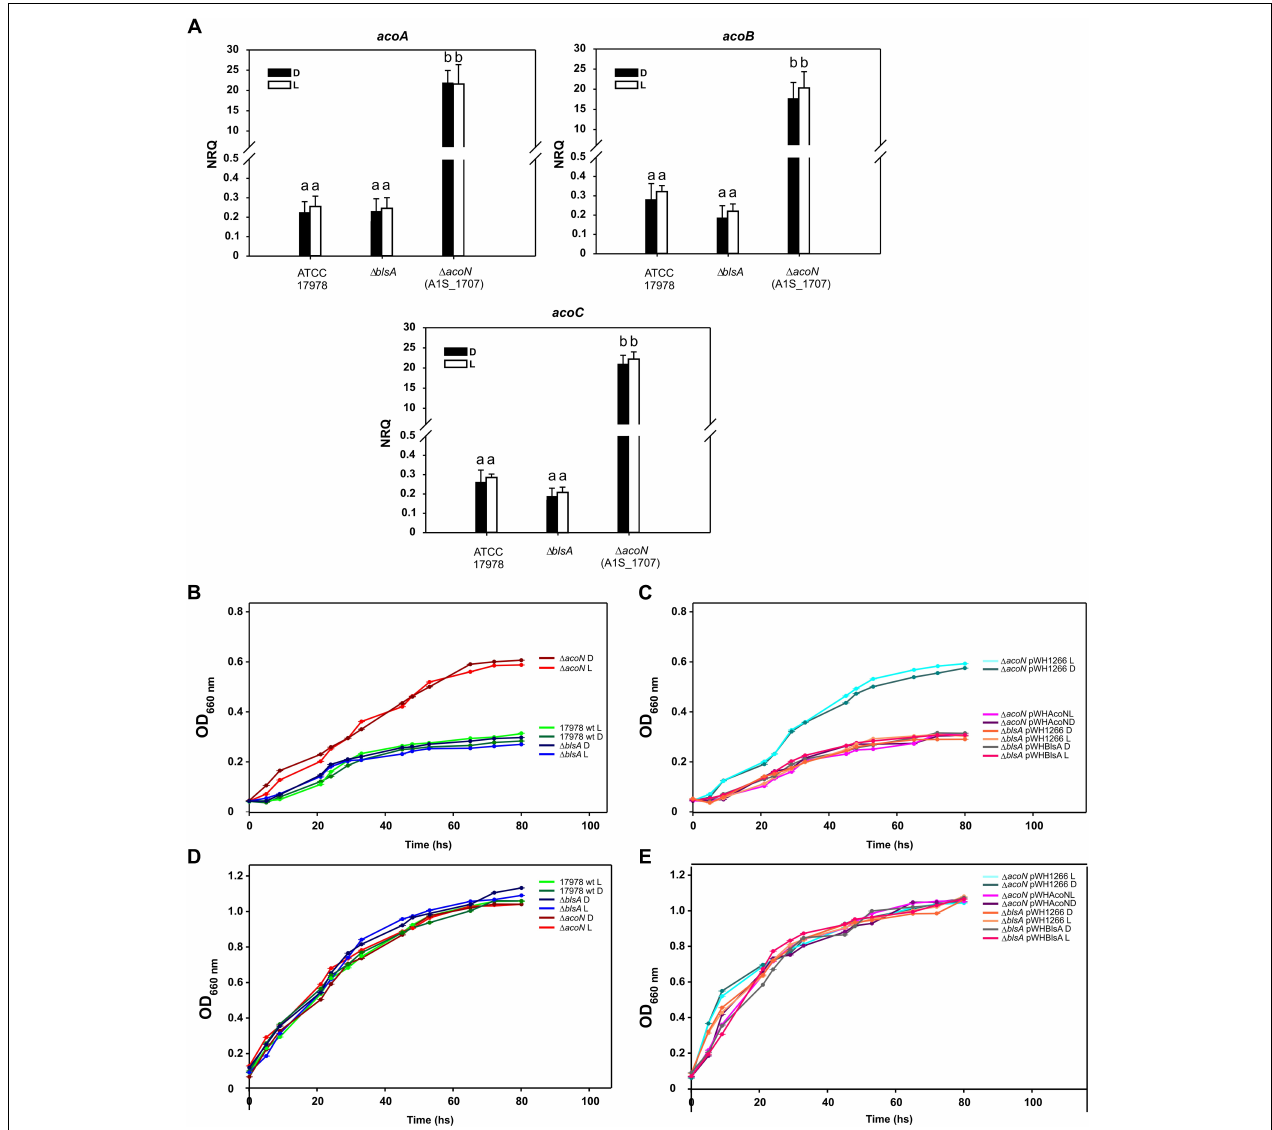
FIGURE 8 | Light does not modulate acetoin catabolism at higher temperatures. (A) Estimation of the expression levels of representative genes components of the acetoin catabolic cluster, acoA–C , by RT-qPCR in A. baumannii ATCC 17978 wild-type as well as (cid:49) blsA and (cid:49) acoN genetic backgrounds under blue light (L) or in the dark (D) at 30 ◦ C. The data shown are mean ± SD of NRQs calculated from transcript levels measured in samples grown in M9 minimal media supplemented with acetoin as sole carbon source under blue light or in the dark at 30 ◦ C, in at least three biological replicates. Different letters indicate significant differences as determined by ANOVA followed by Tukey’s multiple comparison test ( p < 0.01). (B,C) Growth curves in M9 minimal media supplemented with acetoin as sole carbon source of A. baumannii ATCC 17978 wild-type and derivative strains incubated stagnantly under blue light or in the dark at 30 ◦ C. (D,E) Growth curves of A. baumannii ATCC 17978 wild-type and derivative strains in LB media incubated stagnantly under blue light (L) or in the dark (D) at 30 ◦ C. Growth was measured by determining the optical density at 660 nm. The experiments were performed at least in triplicates, including three repetitions for each strain at each condition. Representative results are